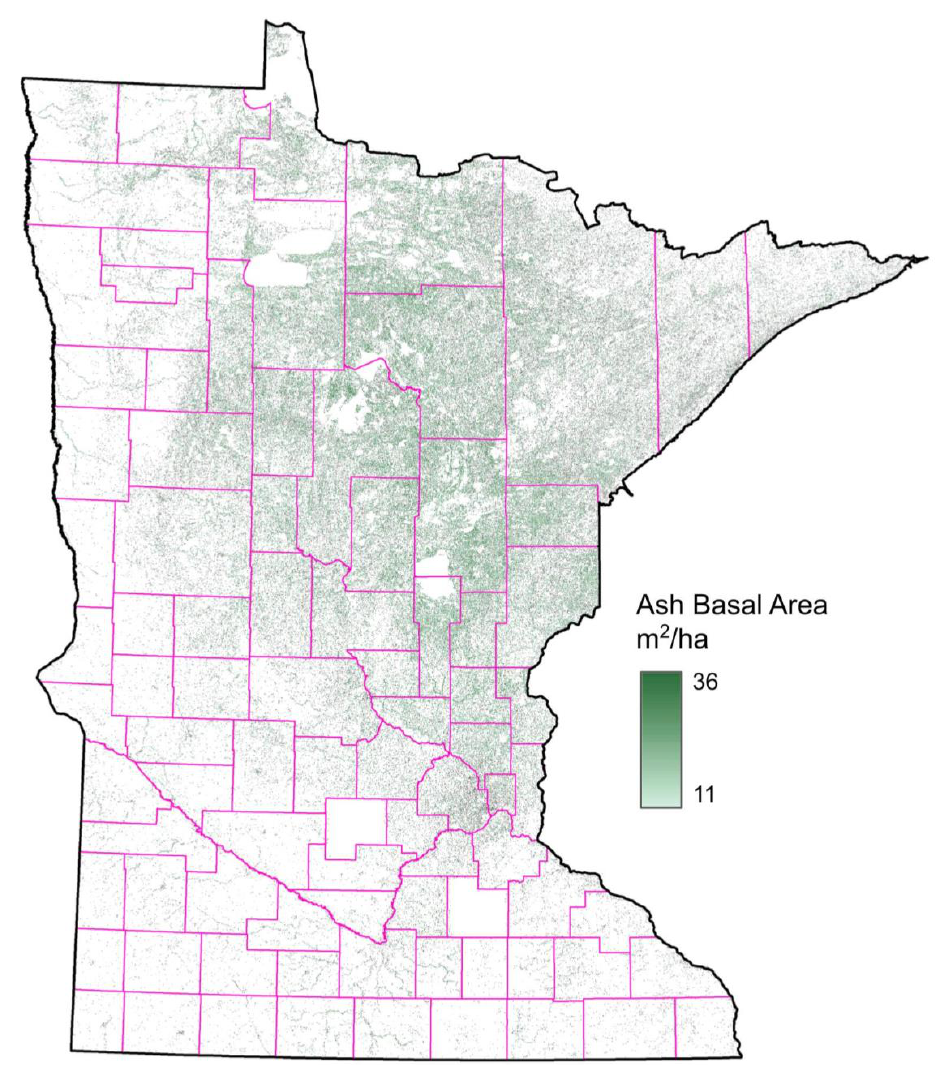
Figure 6. Model-derived 30-m ash abundance map depicting basal area based on presence/absence map and lidar canopy height model with county boundaries in Minnesota,